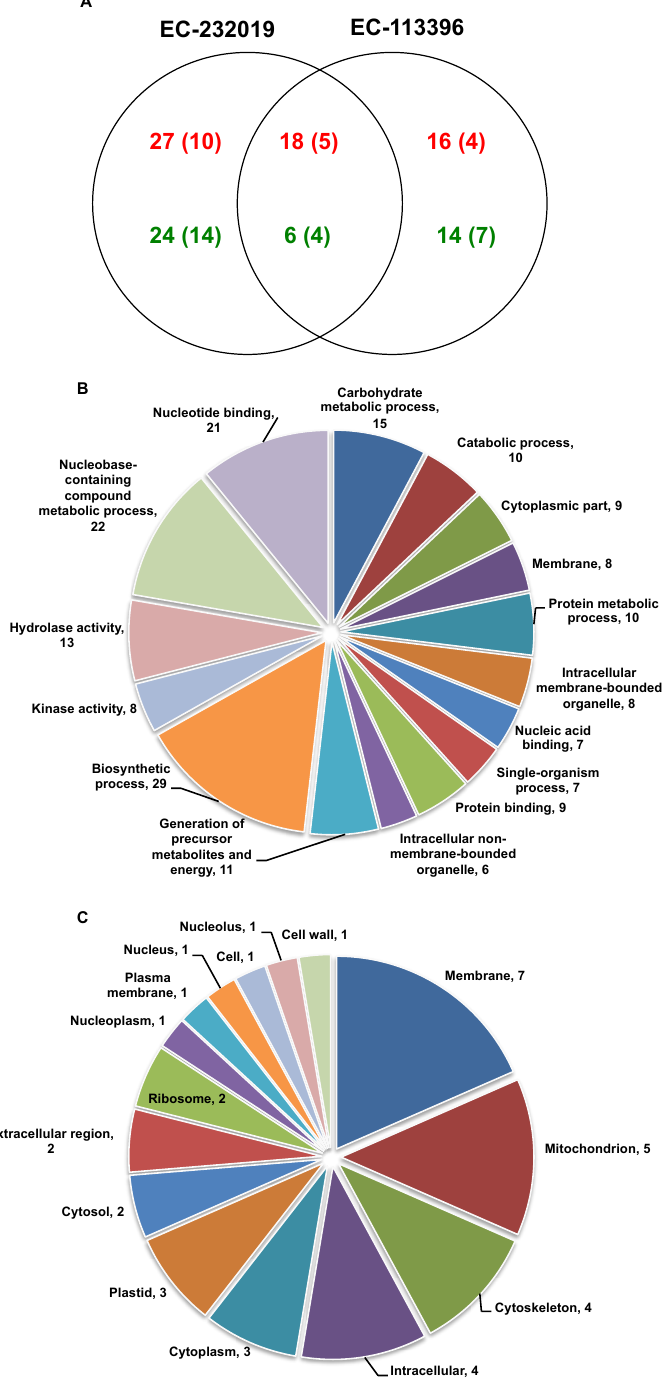
Figure 3. ( A ) Venn diagram showing number of differentially abundant proteins on two-dimensional electrophoretic gels at low P condition in comparison to sufficient P. Number indicated in green color are decreased proteins at low P, while red color are increased proteins at low P. Numbers within parenthesis correspond to proteins with significant Mascot score. Distribution of differentially abundant proteins based on gene ontology with respect to ( B ) biological process and ( C ) cellular